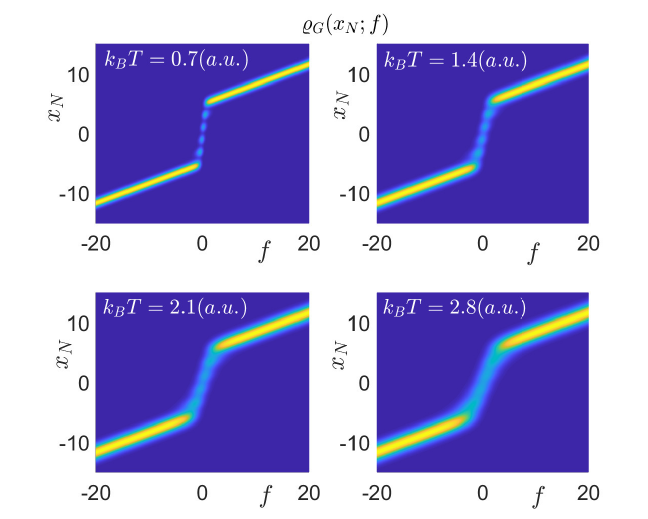
Figure 5. Two-dimensional representation of the Gibbs density (cid:36) G ( x N ; f ) (see Equation (33)) obtained with N = 5, (cid:96) = 1 (a.u.), k = 15 (a.u.) and k B T = 0.7, 1.4, 2.1, 2.8 (a.u.).